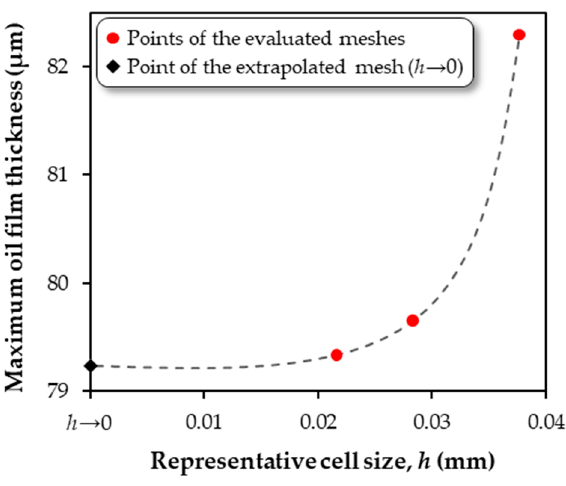
Figure 3. Qualitative representation of the grid convergence study.